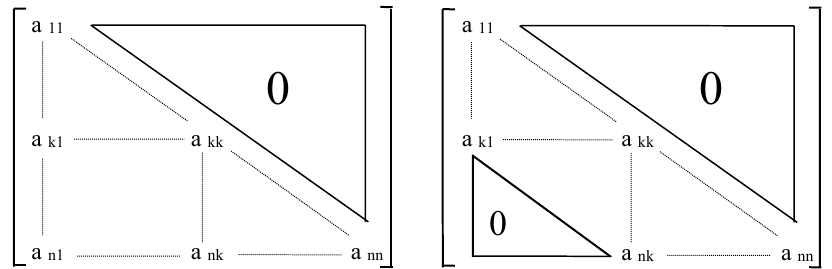
Figure 3. Matrices A & B used to calculate the turbulent fluid velocity seen by the particle along its path. P é trissans et al. [162] later proposed a more effective model, less computer time- consuming, based on different time series, an autoregressive–moving-average ARMA (2,1) process, using a second-order time series and a first moving average. The model was able to generate the Wang and Stock’s Lagrangian correlation functions and predicted the effect of negative